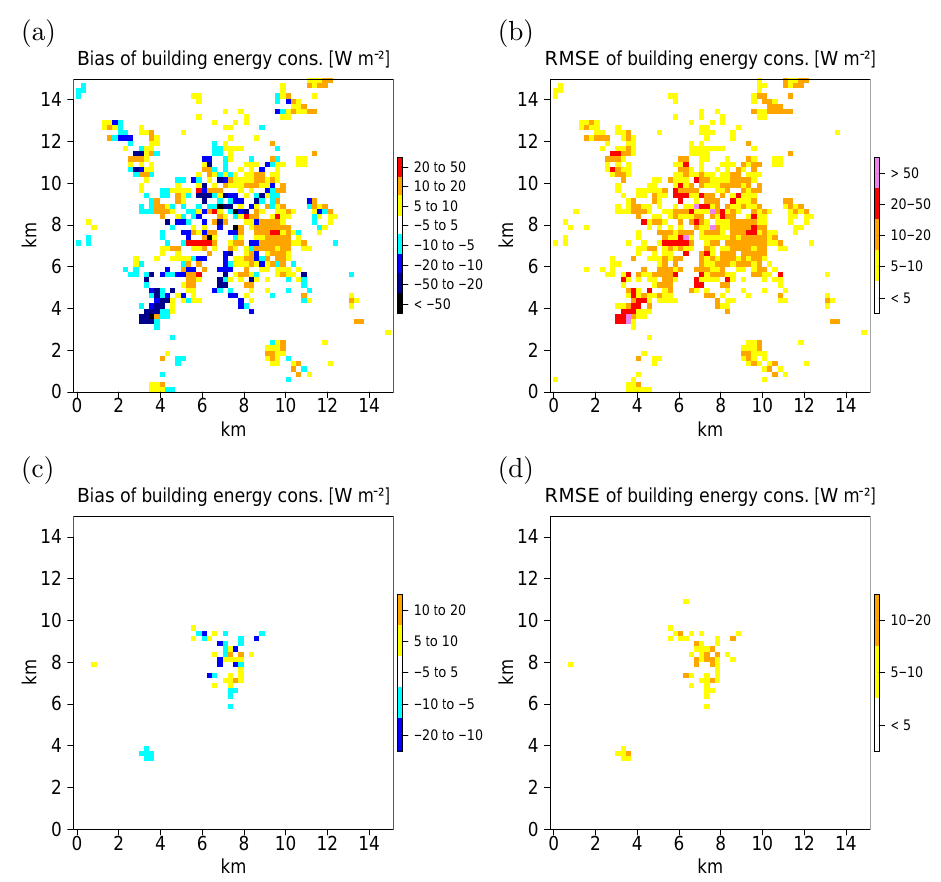
Figure 8. Evaluation of the spatio-temporal variability of simulated building energy consumption in the agglomeration of Toulouse for the MAP model configuration. (a) Bias for DJF, (b) root mean square error (RMSE) of the daily values for DJF, (c, d) same as (a, b) , but for JJA. The horizontal resolution is 250m ×